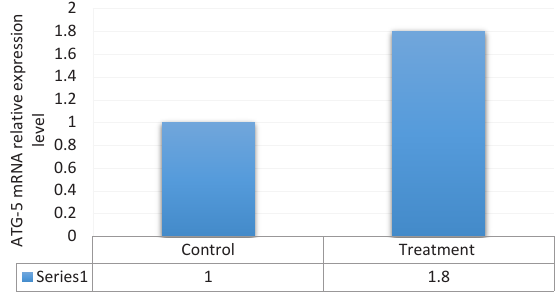
Figure 4. PAHE effects on the expression of autophagy ATG-5 gene expression in the animal model of ER + breast cancer. Note. PAHE: Physalis alkekengi hydroalcoholic extract; RT-PCR: Real-time polymerase chain reaction; ATG-5: Autophagy- related gene-5; ER: Estrogen receptor. The control group was studied with any administration while the treatment group was treated with the more effective dosage of PAHE (50 mg/kg) for 16 days. The relative ATG-5 mRNA expression was directly measured based on breast tumors using the RT-PCR assay after 21 days ( P = 0.037).